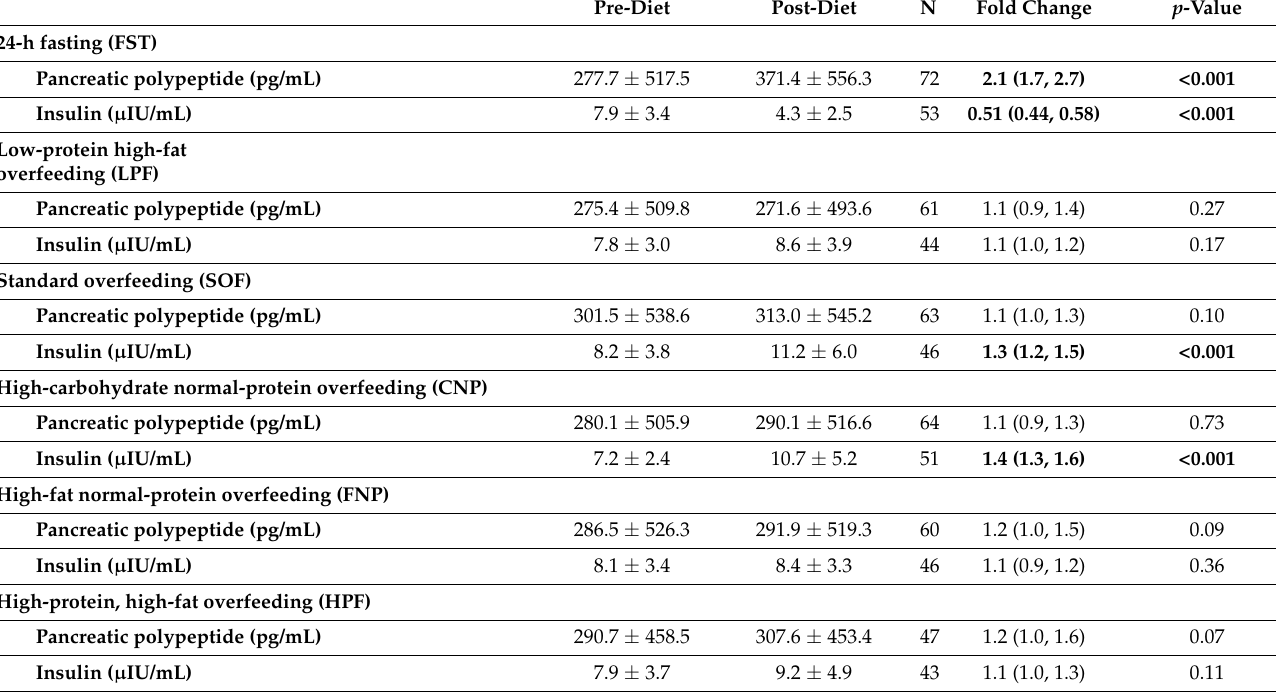
Figure 4. Changes in plasma pancreatic polypeptide (panel ( A )) and insulin (panel ( B )) concentrations after 24-h fasting and low-protein overfeeding. Error bars represent geometric mean with 95% CI. Asterisks represent significant changes in hormone concentrations with a p < 0.05 by Student’s paired t -test analysis of logarithmic values. The individual fold change in hormone concentration after each dietary condition (shown on the y-axis) was calculated as the ratio between the post- diet value divided the pre-diet value. The sample size refers to volunteers who had valid data for both pre-diet and post-diet measurements. Table 3. Plasma pancreatic polypeptide and insulin concentrations before and after each dietary intervention.